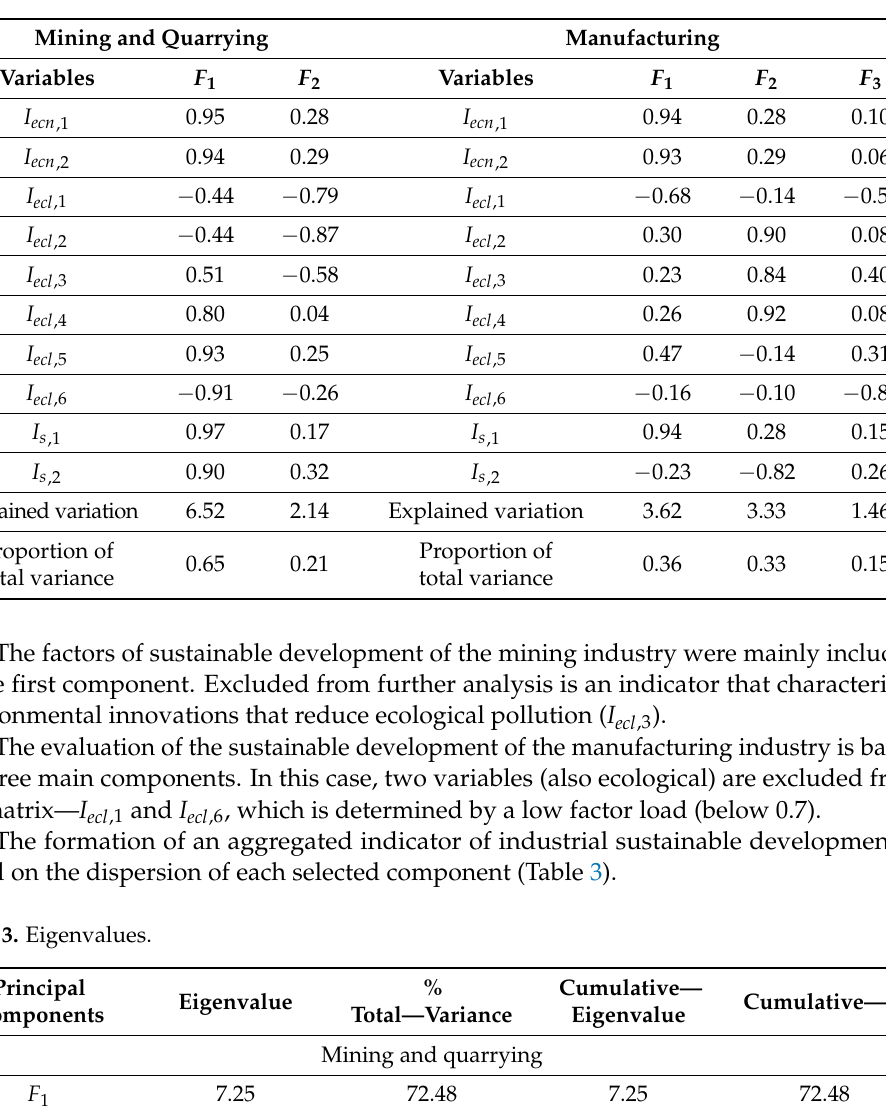
Table 2. Principal components and factor loadings for two sectors of the economy (Varimax raw).